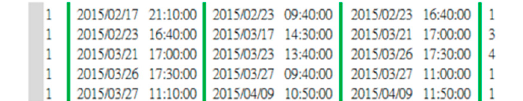
Figure 3. An illustration of the relationships between NAN time, time condition, and NAN period.